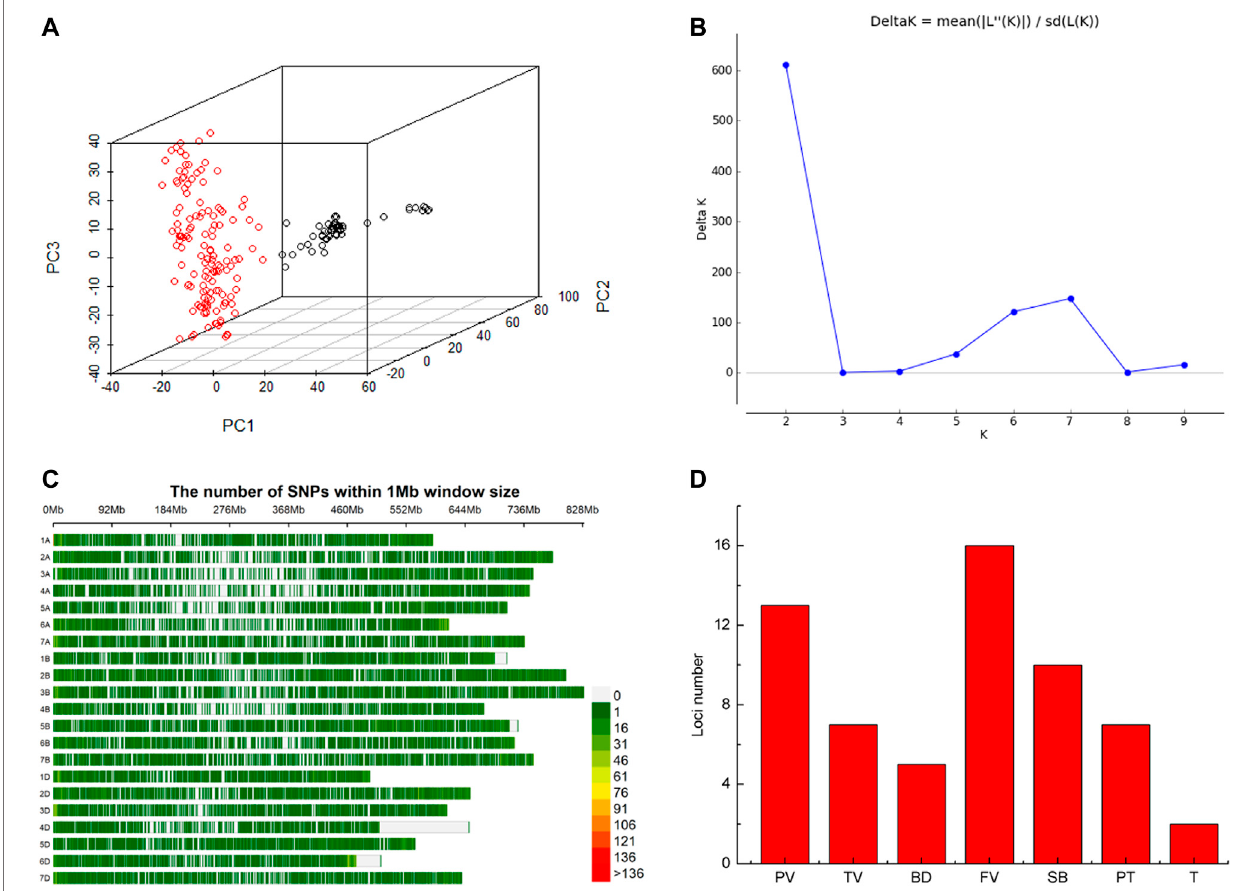
FIGURE 1 | Structure of the association panel of 192 Chinese spring wheat varieties for genome-wide association study (GWAS), distribution of SNPs and signi fi cant loci revealed by GWAS. (A) Structure of association panel. (B) Broken line of delta K. (C) Distribution of SNPs on chromosomes. (D) Histogram plot of loci number signi fi cantly associated with RVA parameters via GWAS based on BLUP